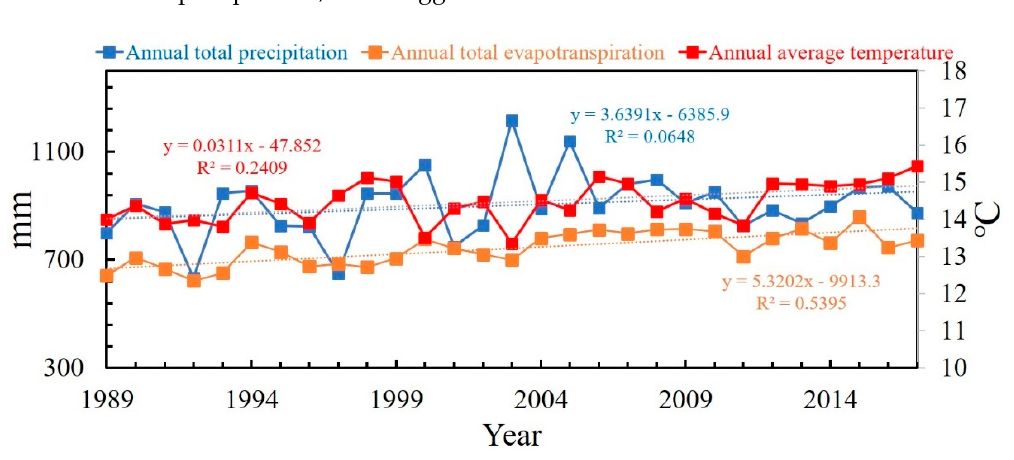
Figure 9. Changes in annual total precipitation, total evapotranspiration, and the average temperature in the Huai River Basin during 1987–2017.